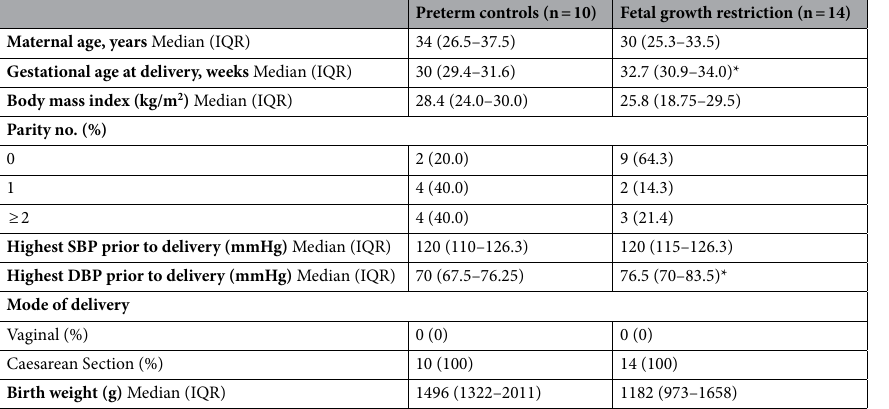
Table 3. Patient characteristics of women with fetal growth restriction and control samples for gene (mRNA) expression studies. BMI data unavailable for n = 3 preterm controls, n = 1 fetal growth restriction sample. *p < 0.05.